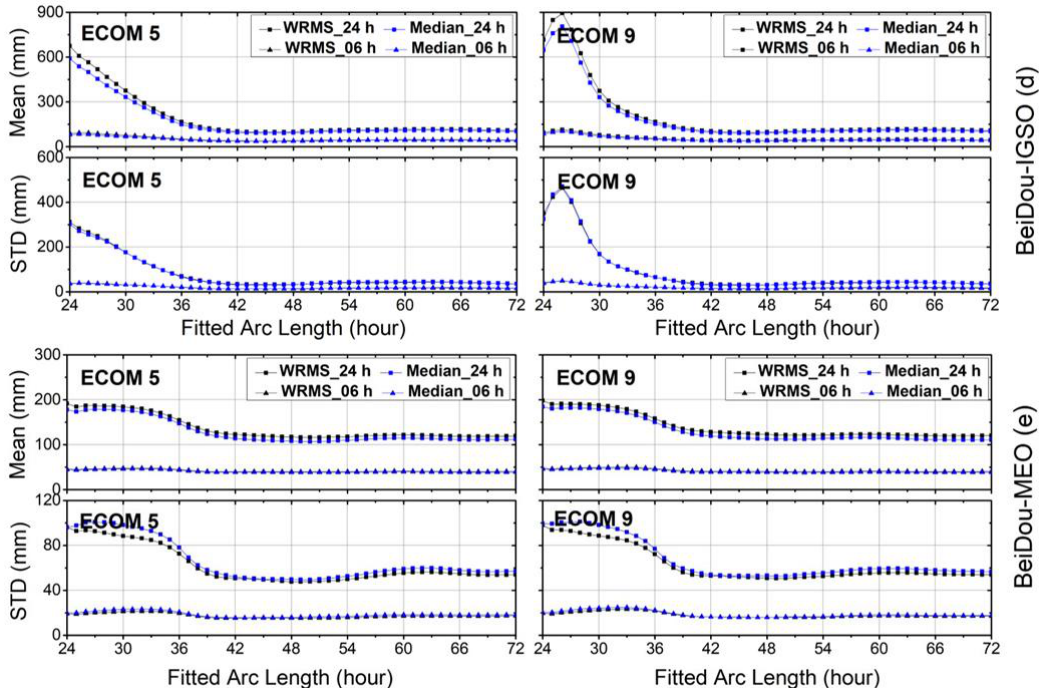
Figure 7. The means and standard deviations (STDs) of weighted root-mean-square (WRMS) and median residuals for orbit differences between predicted orbits and precise ephemerides after Helmert frame transformation over the first 6 h and full 24 h intervals for BeiDou inclined geo-synchronous orbit (IGSO)/medium earth orbit (MEO). Results for reduced Empirical Center for Orbit Determination in Europe Orbit Model (ECOM-5) are shown on the left and for nine-parameter (ECOM-9) on the right planes.